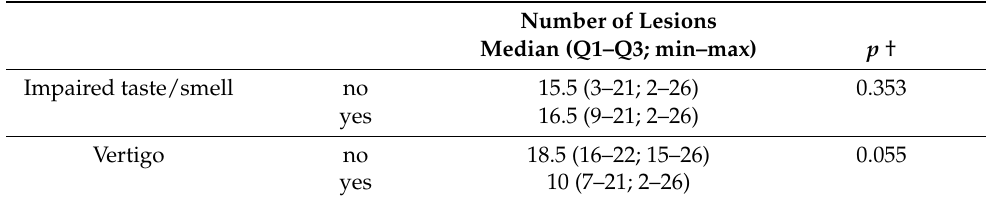
Table 7. Display of the number of lesions in relation to olfactory damage and vertigo.